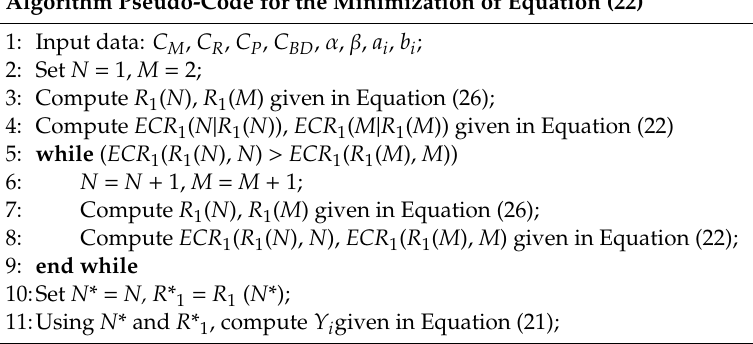
Table 2. Algorithm to obtain the optimal solution for strategy 1. Algorithm Pseudo-Code for the Minimization of Equation